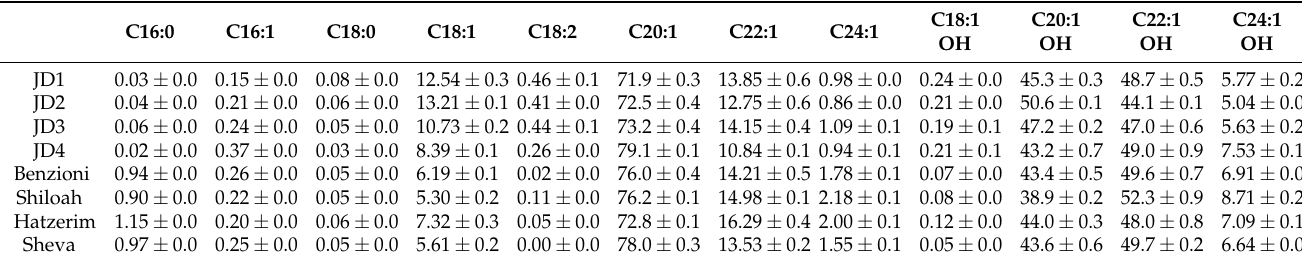
Table 1. Chemical composition of Jojoba wax. Benzioni, Shiloah, Hatzerim and Sheva, as well as commercial batches (JD1–4) used in Figure